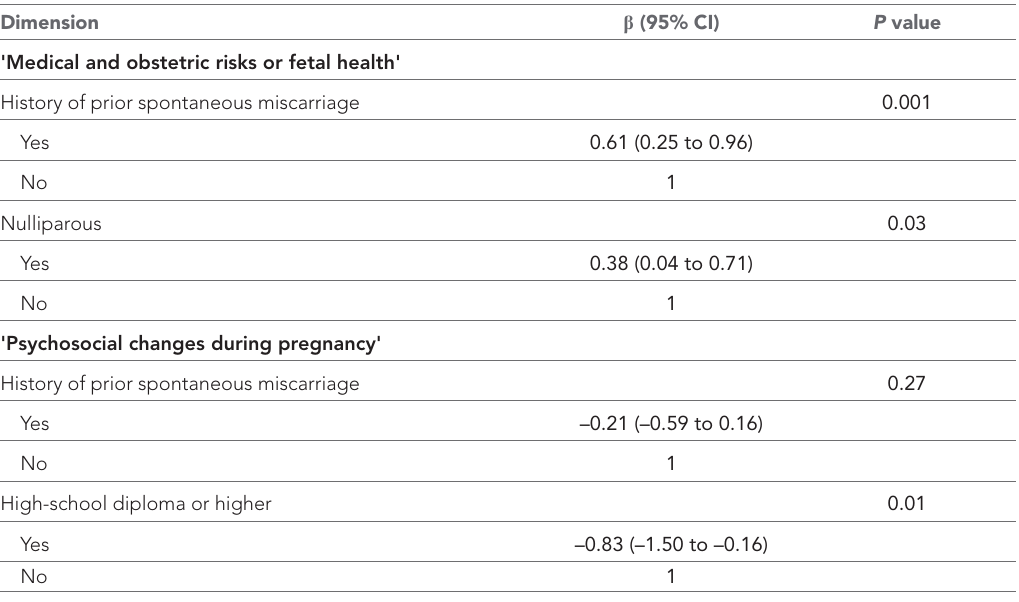
Responses of pregnant women (in the first trimester) on the four items constituting the dimension “medical and obstetric risks/fetal health” of the Antenatal Perceived Stress Inventory, according to the presence or absence of prior spontaneous miscarriage.